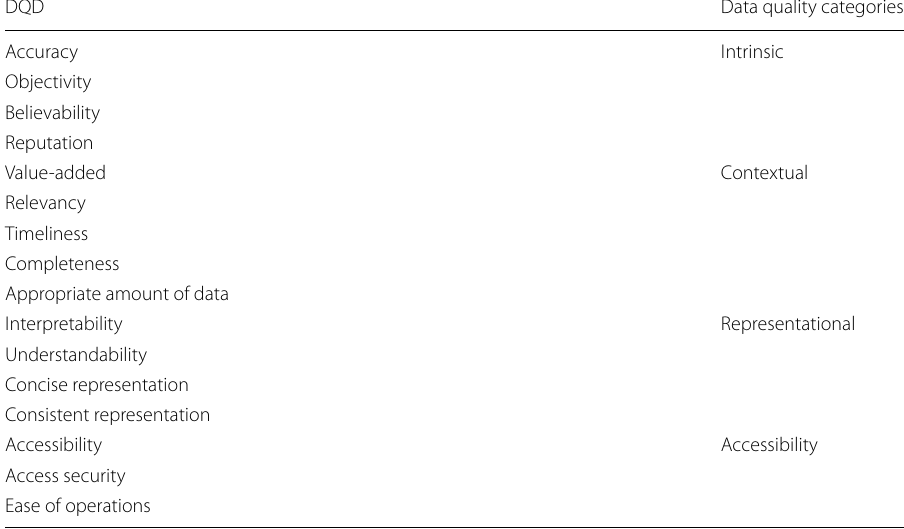
Table 1 DQD and their categories